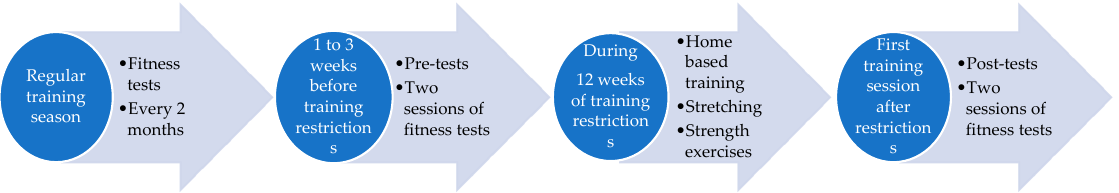
Figure 1. Training and test sessions timeline.